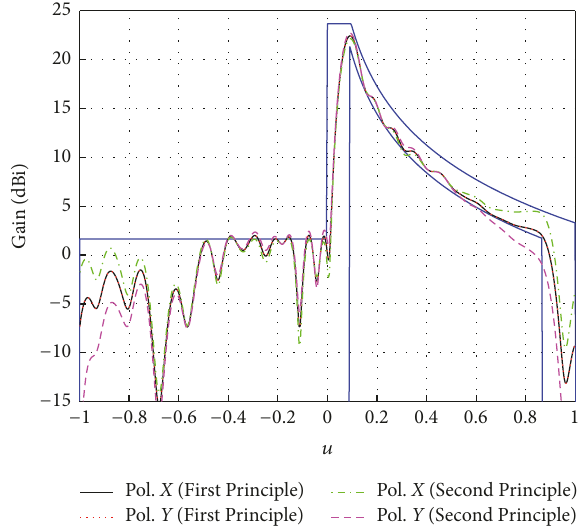
Figure 5: Differences between the First and the Second Principles of Equivalence for both linear polarizations in the elevation cut of a LMDS pattern synthesized using the POS formulation of the First